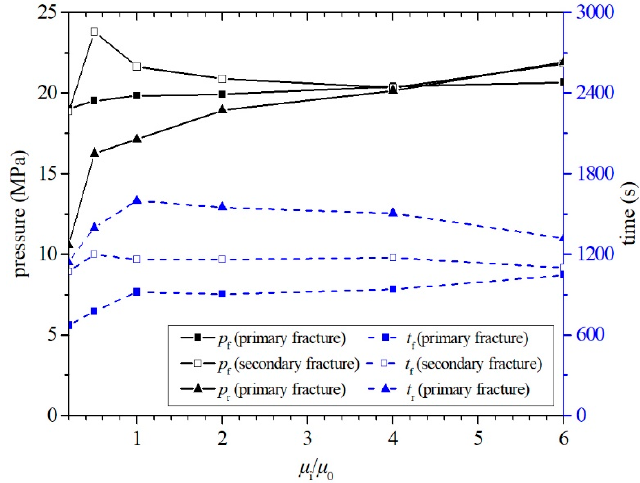
Figure 20. The fracture radius of models with different hydraulic fluid viscosity when the primary fractures reach the boundary.